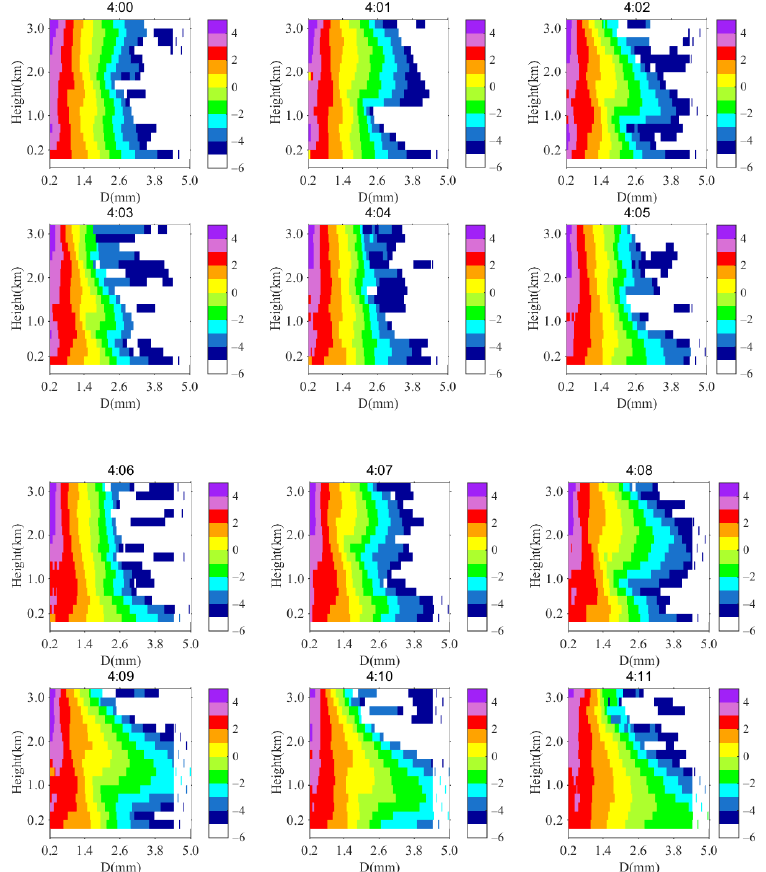
Figure 5. Vertical evolution of DSD every 1 min detected by MRR below 0 °C layer between 4:00 and 4:11 on 16 June 2021.